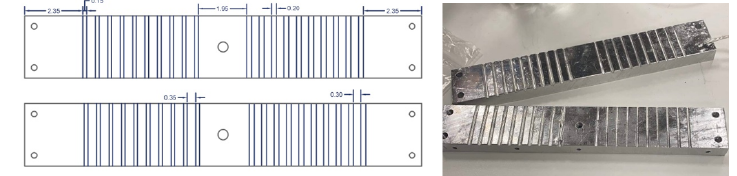
Figure 2. Custom-made aluminum mold.